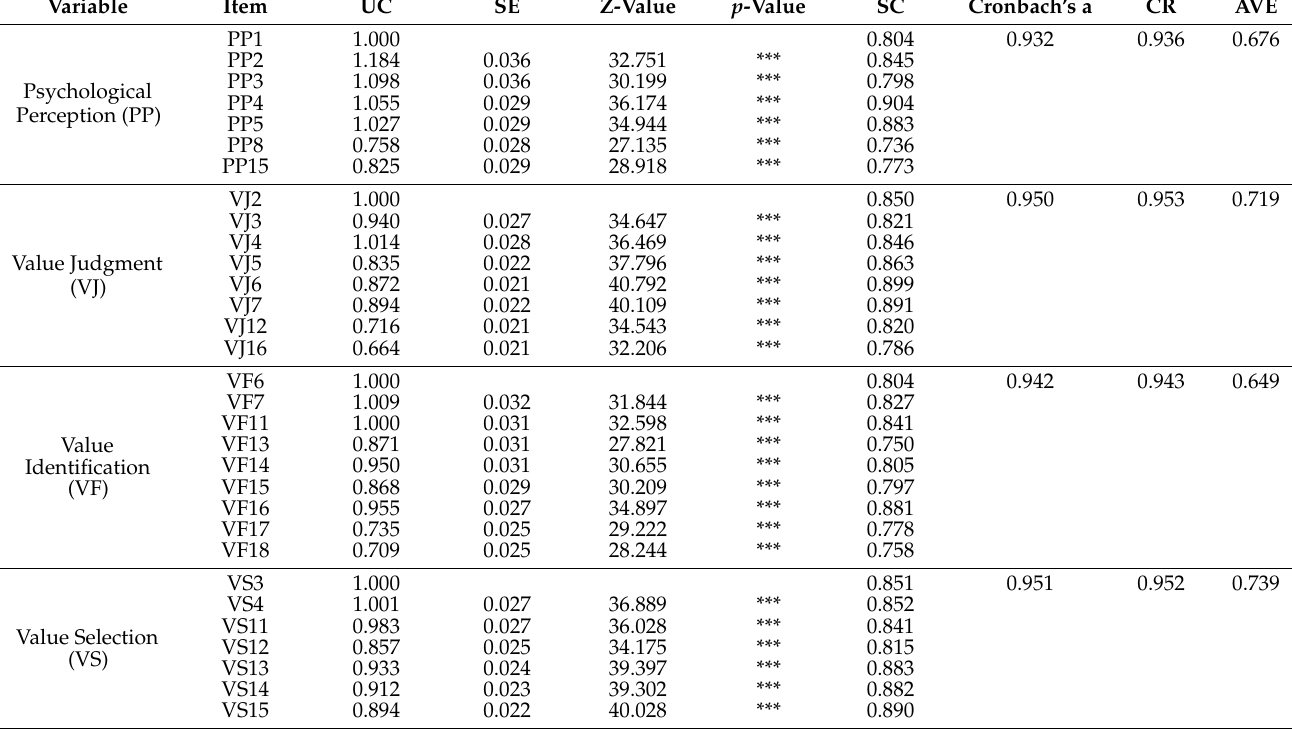
Table 3. Reliability and validity